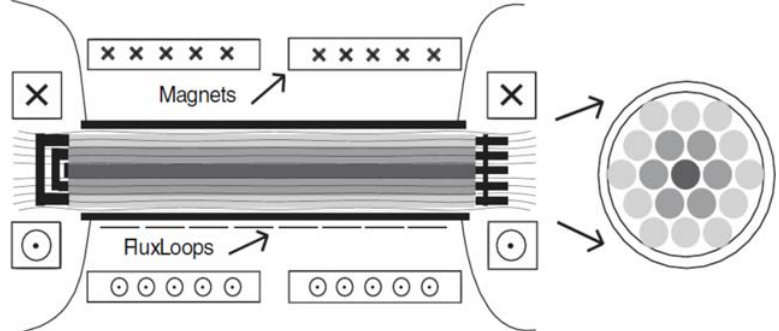
Figure 11. A schematic of the UW-Madison line-tied pinch experiment. The solenoidal magnets produce a nearly uniform magnetic field between the two ends. The anode plate is on the left and drawn to highlight its electrical conductivity. The hexagonally packed cathode array of plasma guns (shown on the right) breaks into three independently controllable regions of plasma represented by shadings in gray.